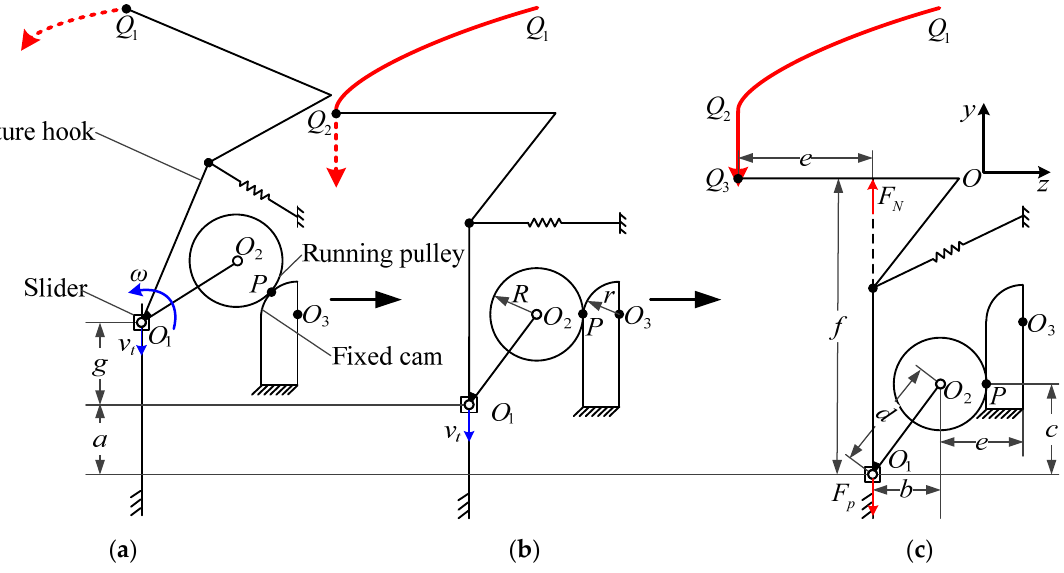
Figure 16. Schematic diagram of model parameters and trajectory formation process. ( a ) Initial state; ( b ) end state of curve segment trajectory; ( c ) locked state.